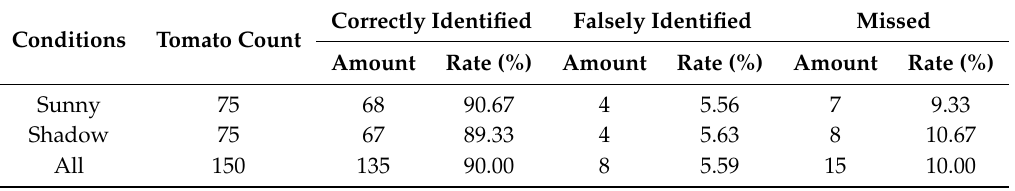
Table 3. The detection results of the proposed method under different lighting